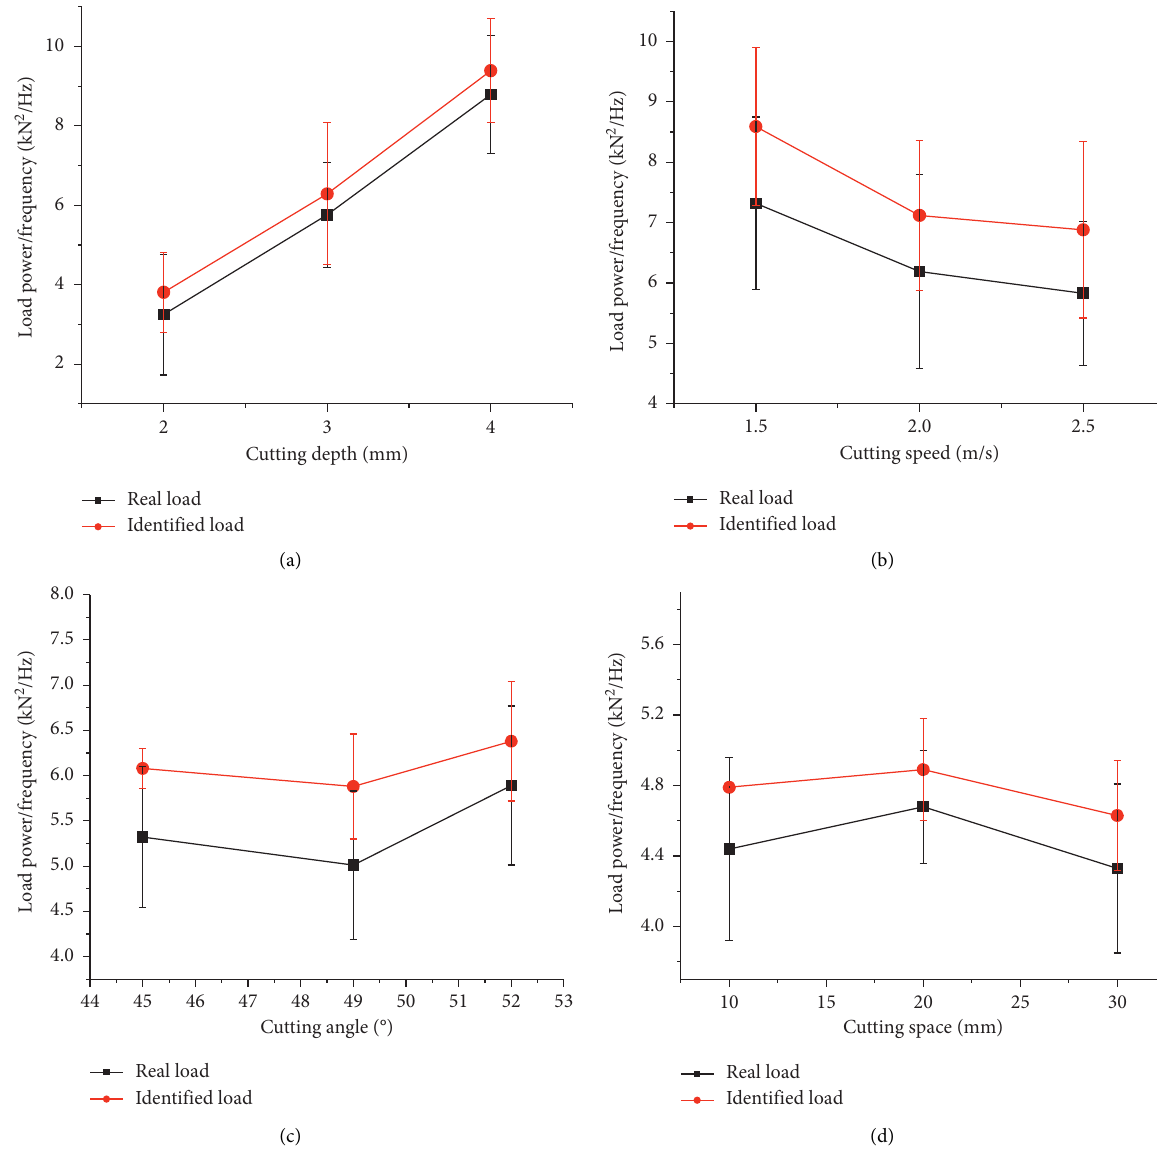
Figure 5: Comparison curves of real load and identified load: (a) cutting depth, (b) cutting speed, (c) cutting angle, and (d) cutting space.